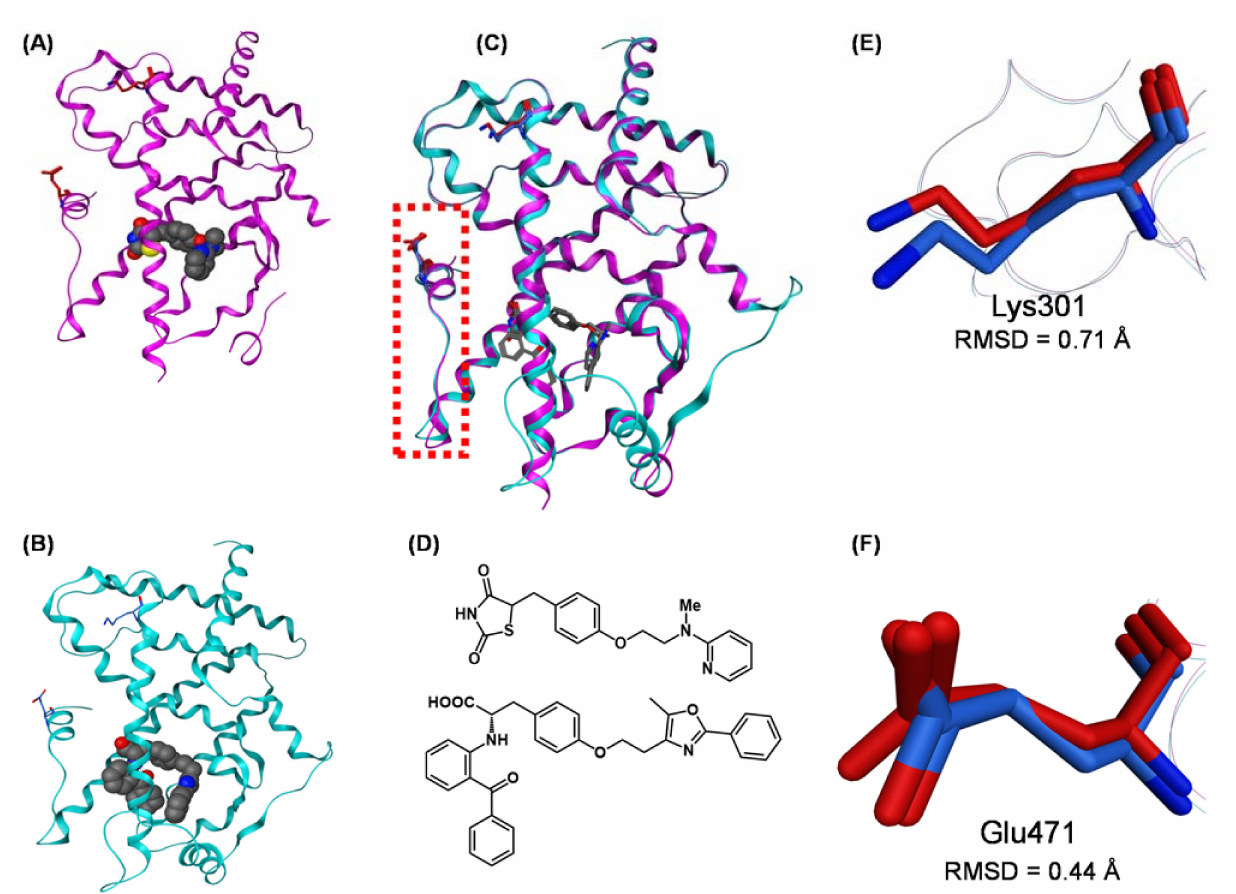
Figure 20. ( A , B ) Crystal structures of hPPAR χ LBD–rosiglitazone (full agonist) complex (PDB: 2PRG) and hPPAR χ LBD– farglitazar (full agonist) complex (PDB: 1FM9). ( C ) The superimposed structures of hPPAR χ LBD–rosiglitazone and hPPAR χ LBD–farglitazar complexes. Both ligands are depicted as cylinder models, and Lys301 and Glu473 are highlighted as cylinder models in magenta (rosiglitazone complex) and cyan (farglitazar complex). The N -terminal AF2 region (H12 helix) is highlighted by a light red dotted box. ( D ) Chemical structures of rosiglitazone and farglitazar. ( E ) Zoomed view of the superimposed Lys301 of the hPPAR χ LBD–rosiglitazone complex and hPPAR χ LBD–farglitazar complex. Lys301 is highlighted as a cylinder model in magenta (rosiglitazone complex) or blue (farglitazar). ( F ) Zoomed view of the superimposed Glu473 of the hPPAR χ LBD–rosiglitazone complex and hPPAR χ LBD–farglitazar complex. Glu473 is highlighted as a cylinder model in magenta (rosiglitazone complex) or blue (farglitazar). Lys301 residues are highlighted as a green cylinder